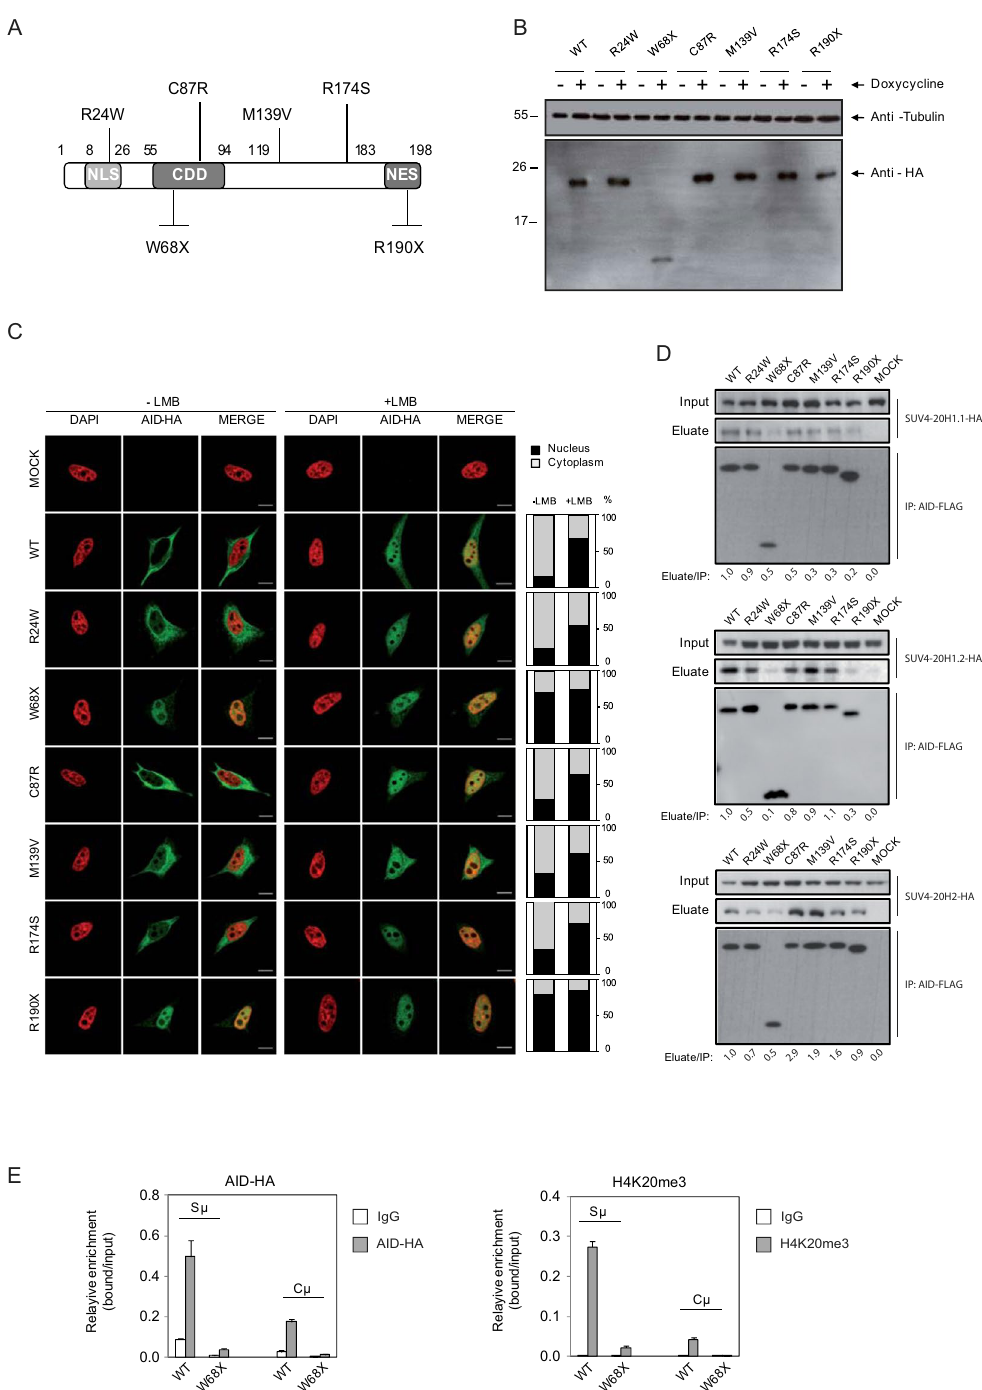
Figure 4. Effects of HIGM2 mutant forms of AID on cell distribution and interaction with SUV4-20H enzymes. ( A ) Primary structure of AID. The upper part of the diagram indicates the four missense mutations related to HIGM2used in our study. The lower part indicates the two selected nonsense HIGM2 mutations. NLS, nuclear-localisation signal; CDD, cytidine deaminase domain; NES, nuclear-export sequence. ( B ) Western blot image showing the inducible expression of AID WT and the various HIGM2 mutants, before and after treatment with doxycycline 500 ng/ml for 48 hours. ( C ) Representative confocal images showing the subcellular localisation of C-terminally hemagglutinin (HA)-tagged human AID in inducible HeLa cells. A total of 20 cells from randomly selected fields were analysed in each experimental condition. The graphs next to the confocal images, show the quantification of the cellular signal of AID within the cells. Light gray section of the bar indicates the average percentage of citoplasmic AID signal. Black section of the bar indicates the average percentage of nuclear AID signal. When nuclear export was inhibited with 50 ng/ml leptomycin B (LMB) for 2 hours, most of the AID translocates from the cytoplasm to the nucleus. Protein products of missense